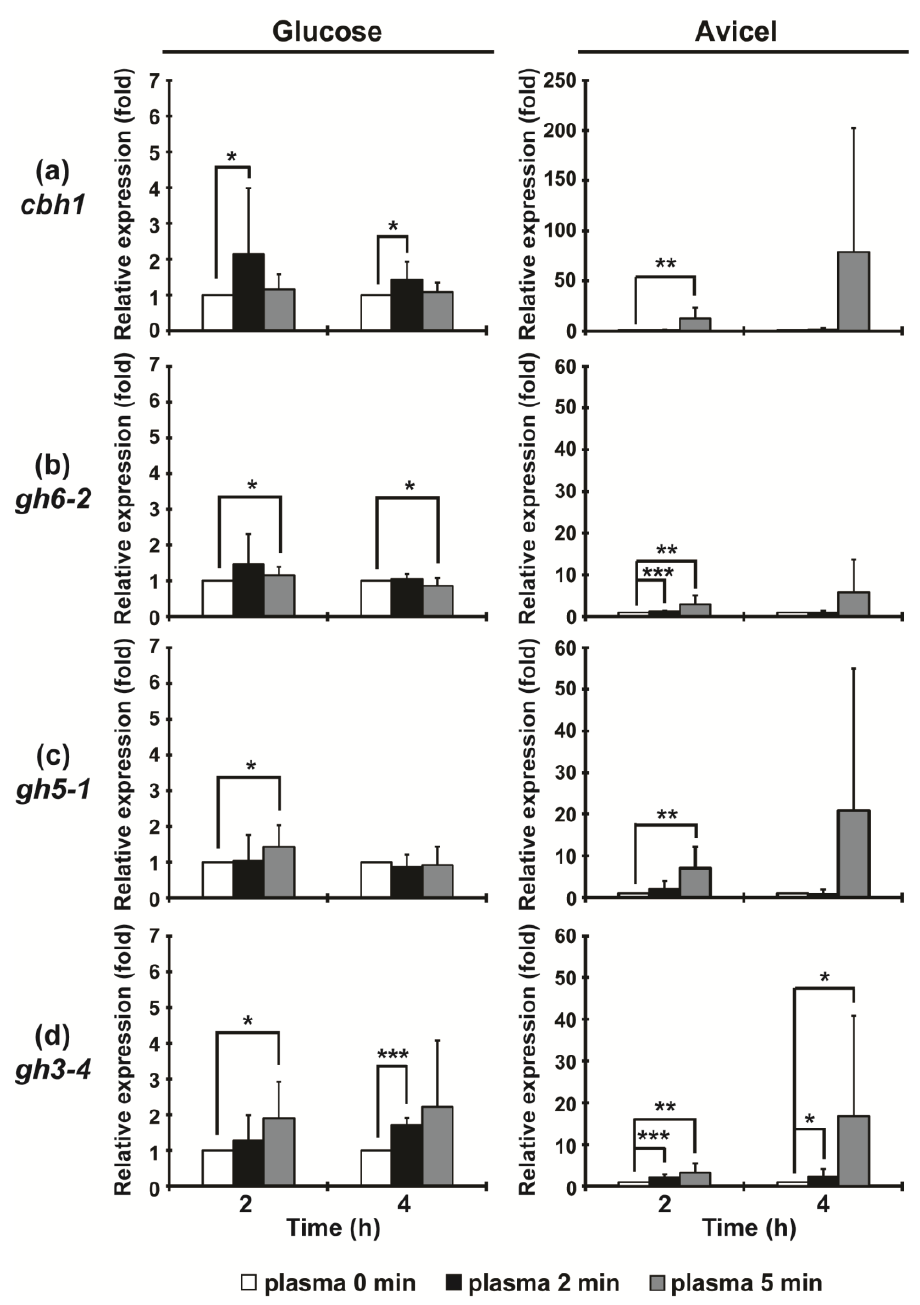
Figure 4. Intracellular mRNA expression of cellulolytic enzymes in fungal hyphae incubated in glucose and Avicel media at 2 and 4 h after plasma treatment (0, 2, and 5 min): ( a ) cbh1 ; ( b ) gh6-2 ; ( c ) gh5-1 ; ( d ) gh3-4. Each value represents the mean of 9 – 12 replicate measurements: * p < 0.05, ** p < 0.01, *** p < 0.001.